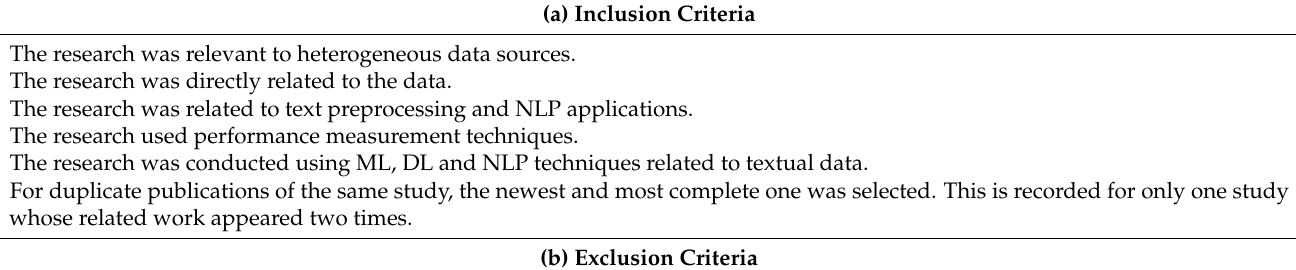
Table 2. ( a ) Inclusion criteria description and ( b ) exclusion criteria